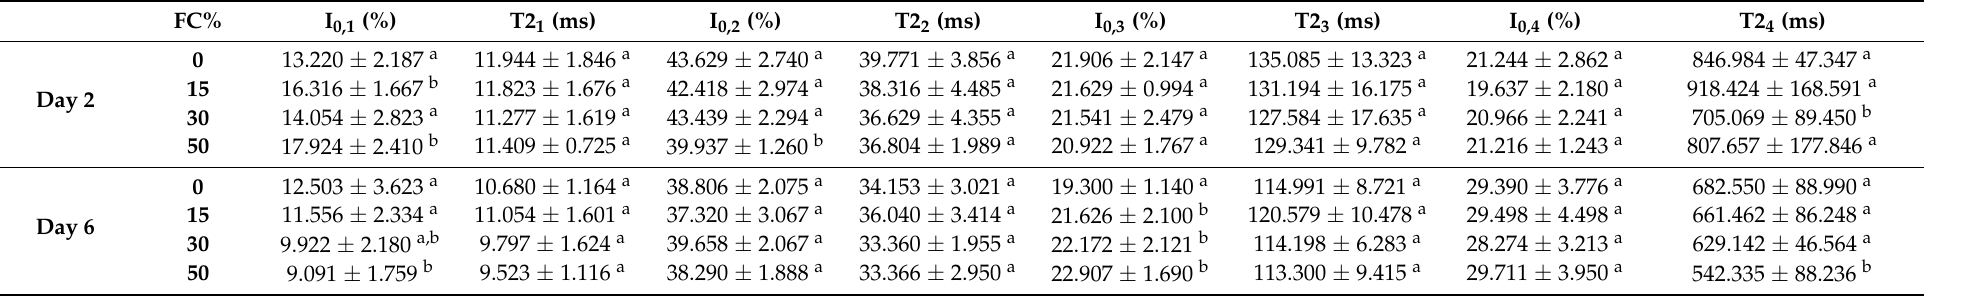
Table 2. Means and standard deviations of discrete coefficients from the exponential decay model for each 1H population, population intensities (I 0 ) are normalised on the total signal